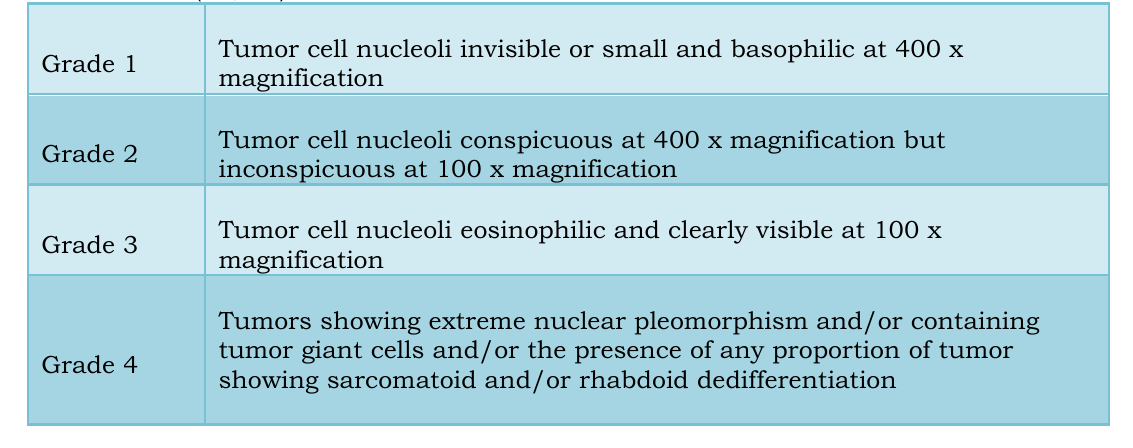
Table 1. The International Society of Urological Pathology grading classification for renal cell carcinoma (58,